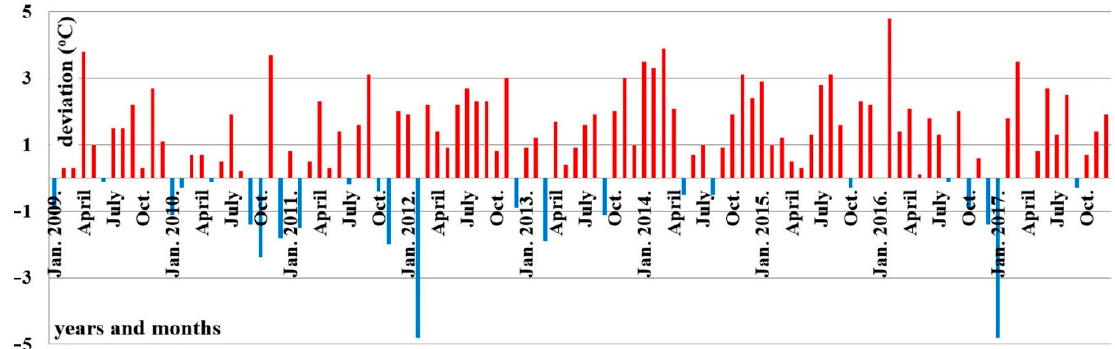
Figure 2. Deviation of the monthly temperature mean (2009–2017) from the 1971–2000 climate normal value in Hungary; based on data [26]. (red: positive deviations, blue: negative deviations).